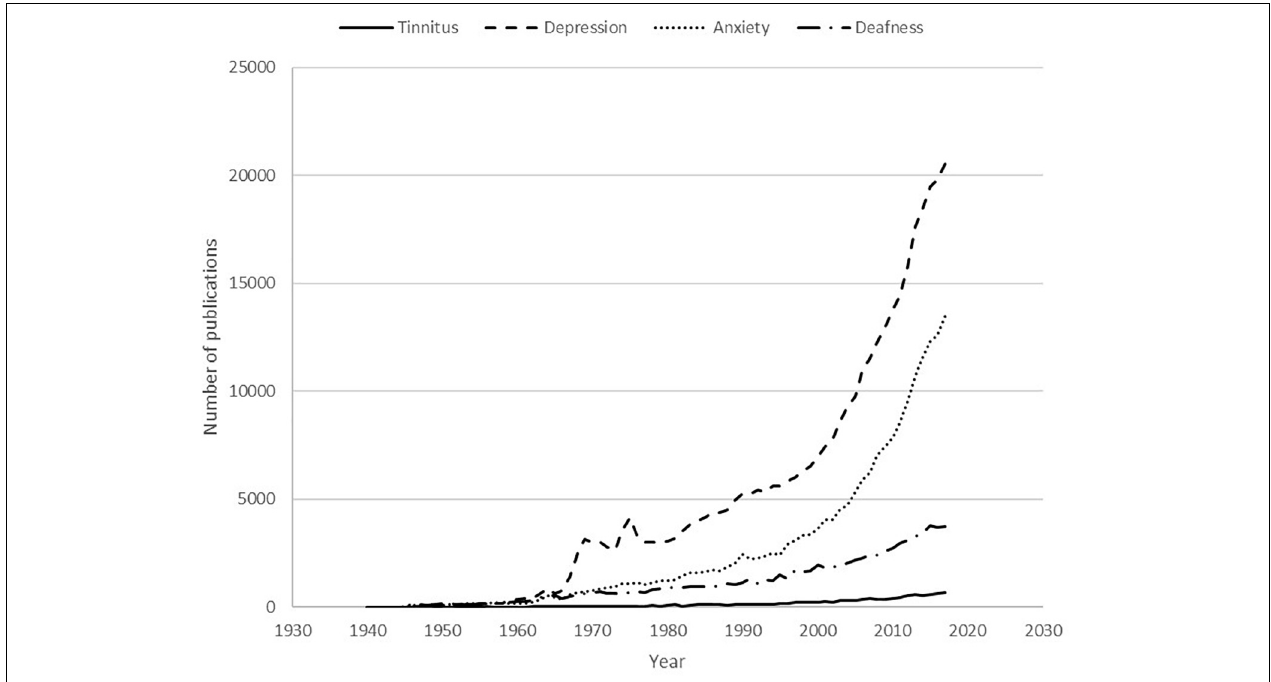
FIGURE 1 | Publications listed on the United States National Library of Medicine PubMed database for the conditions tinnitus, deafness, anxiety or depression in the period from 1940 to 2017.